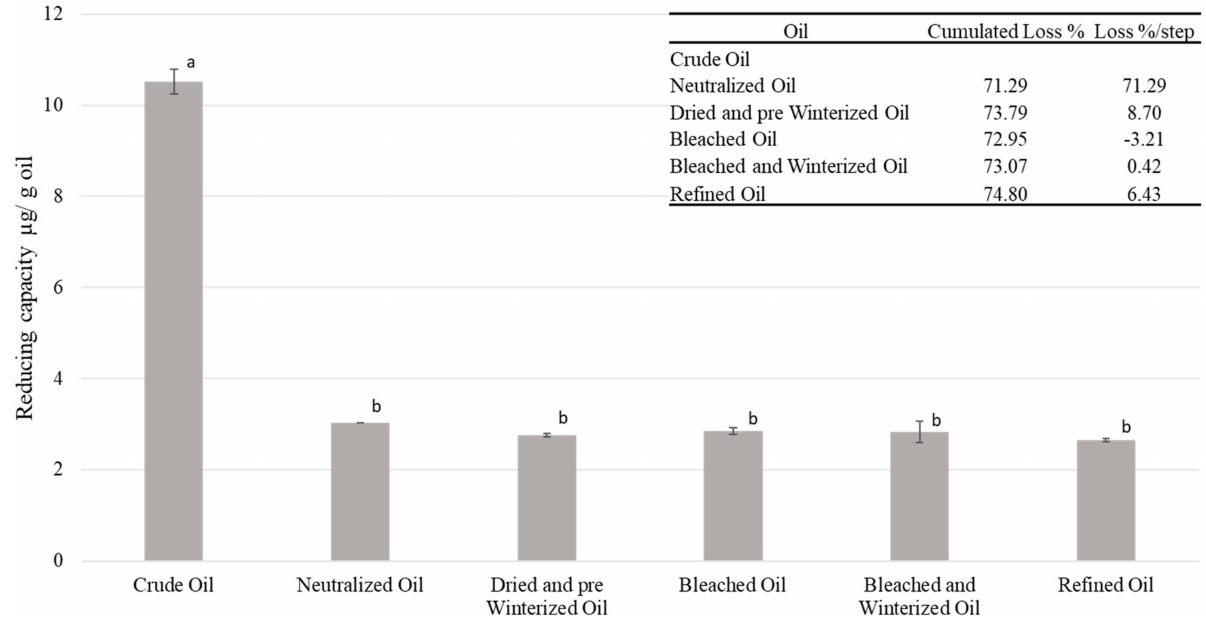
Figure 2. Evolution of the reducing capacity while refining the oil, a,b different letters mean significant differences between steps p < 0.05 (Tukey’s test).